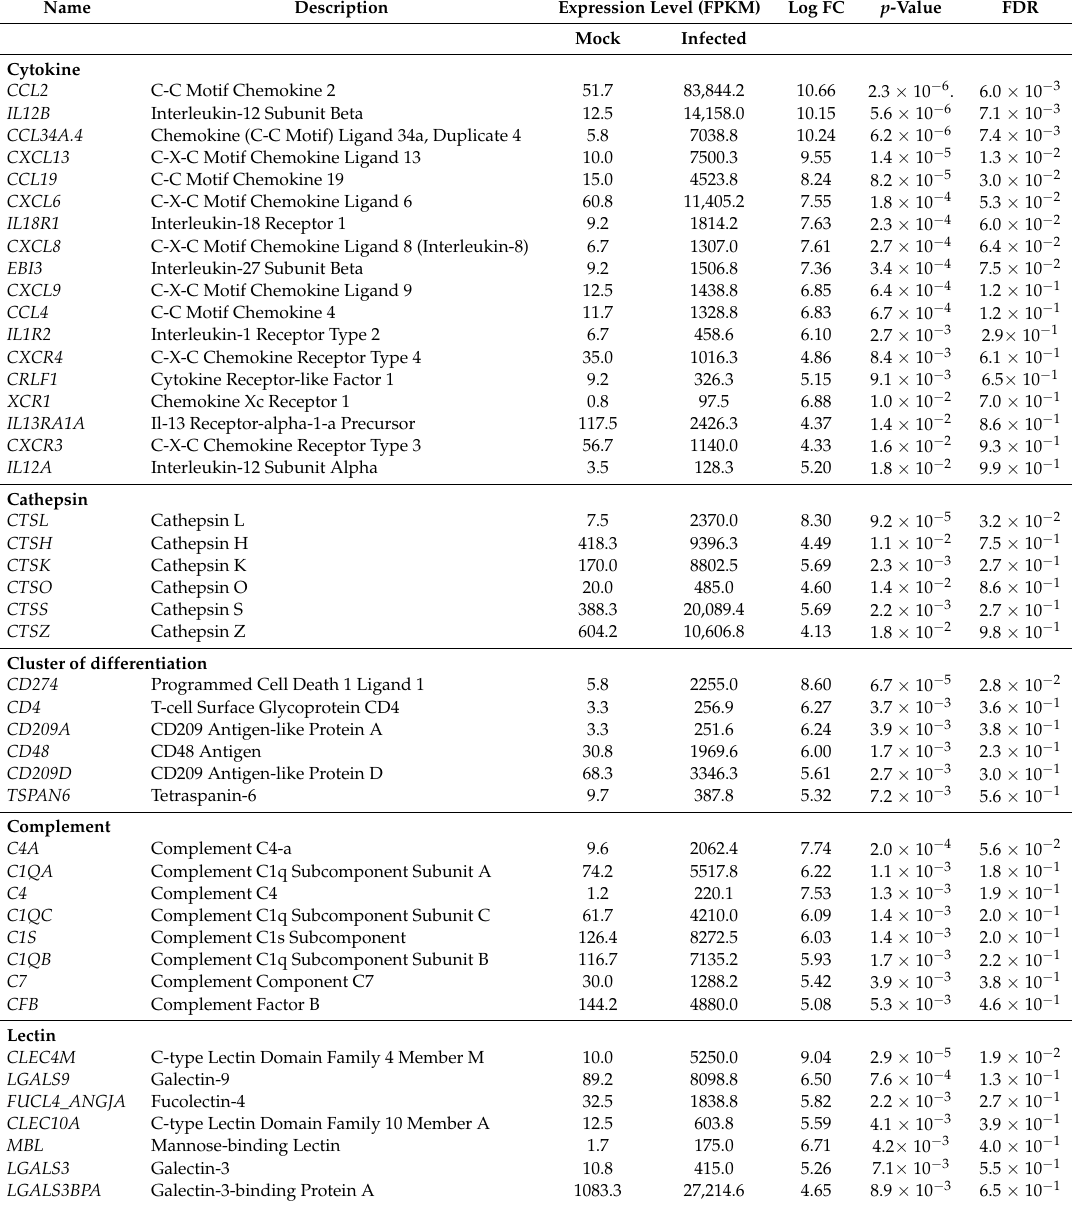
Table 3. Immune relevant differentially expressed genes (DEGs) after NNV